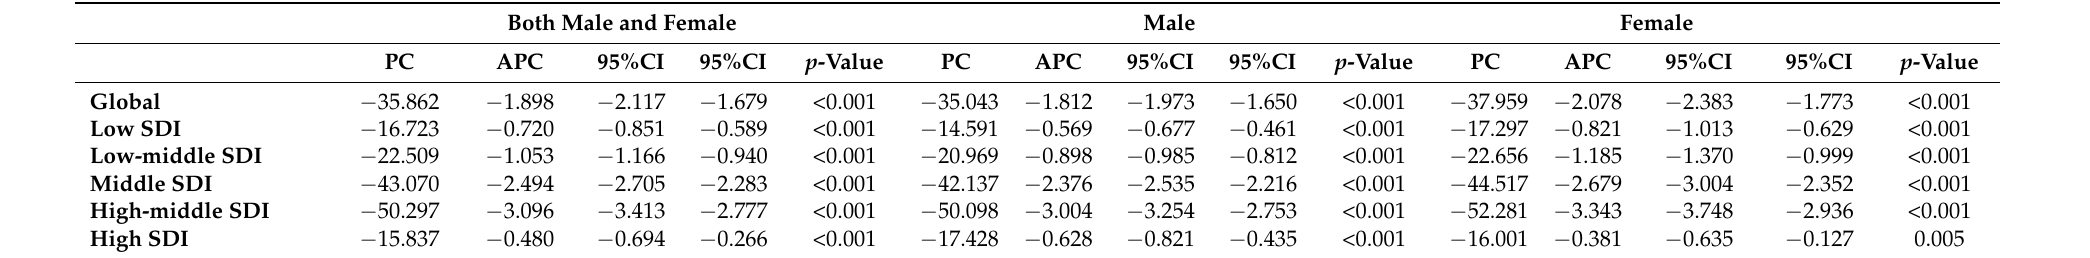
Table 7. Percentage change and annual percentage change of disability adjusted life years of urolithiasis stratified by gender and SDI